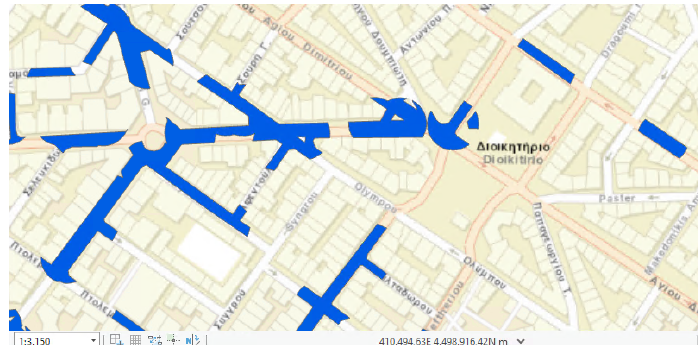
Figure 10. Recycling bin coverage for a particular region in the city of